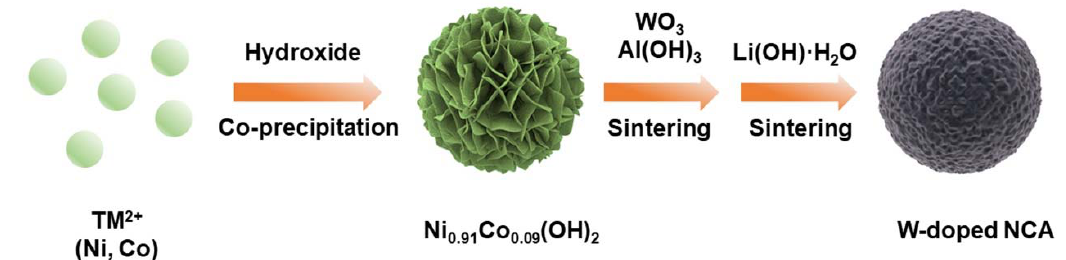
Figure 1. Schematic illustration of the preparation of W-doped NCA cathodes.